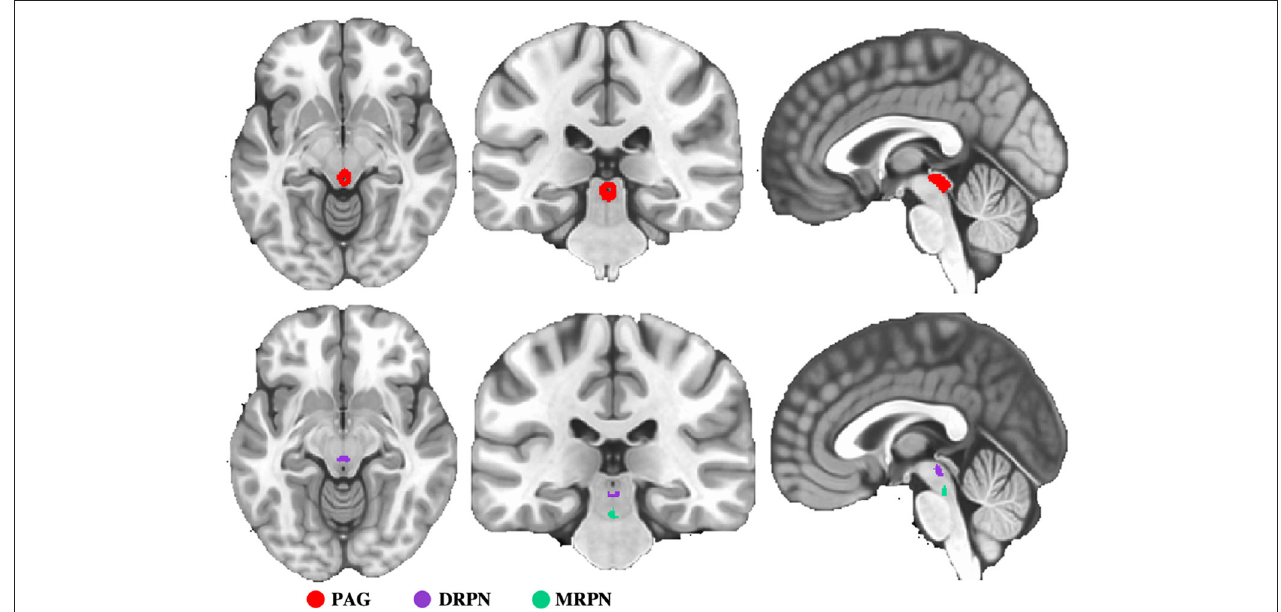
FIGURE 1 | Representation of seed regions. PAG, periaqueductal gray; DRPN, dorsal raphe nuclei; MRPN, medial raphe nuclei.